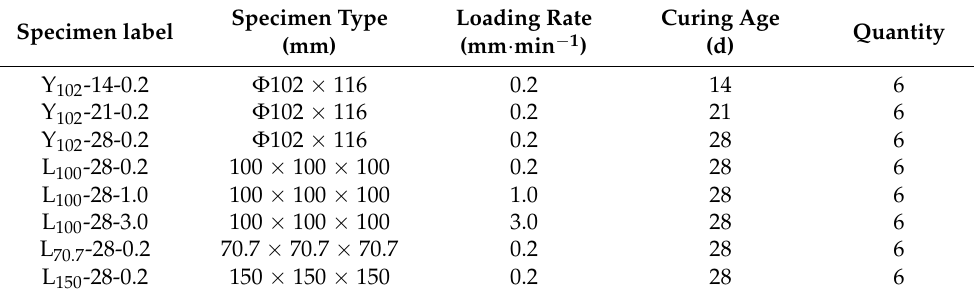
Table 3. Uniaxial compression test under different working